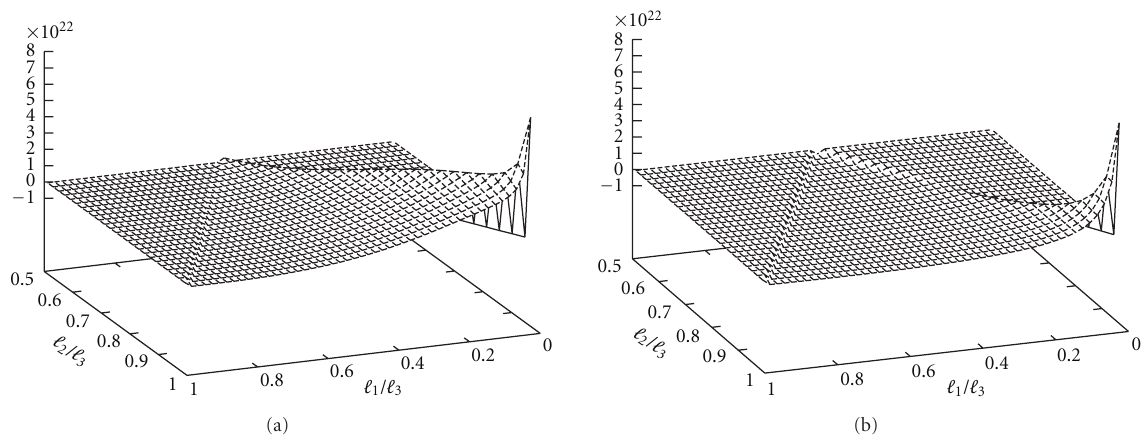
(cid:16) ( G m 1 m 2 m 3 ) − 1 / (2 π ) 2 × 10 22 as a function of (cid:7) 1 /(cid:7) 3 and (cid:7) 2 /(cid:7) 3 where (cid:7) 3 = 200. Both shapes a (1) a (2) (cid:7) 1 (cid:7) 2 (cid:7) 3 (cid:7) 1 m 1 (cid:7) 2 m 2 (cid:7) 3 m 3